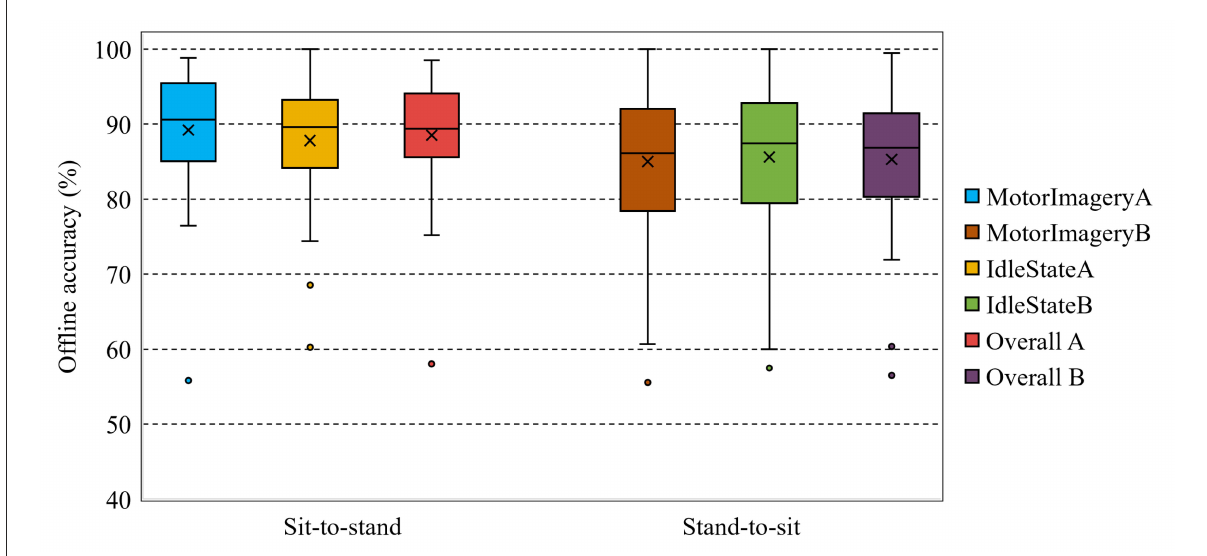
FIGURE6 Classification accuracies (%) estimated with five-fold cross-validation across all participants for the motor imagery vs. idle state classes in the sit-to-stand and stand-to-sit offline experiments. × represents the mean. The Supplementary material section provides the result for each